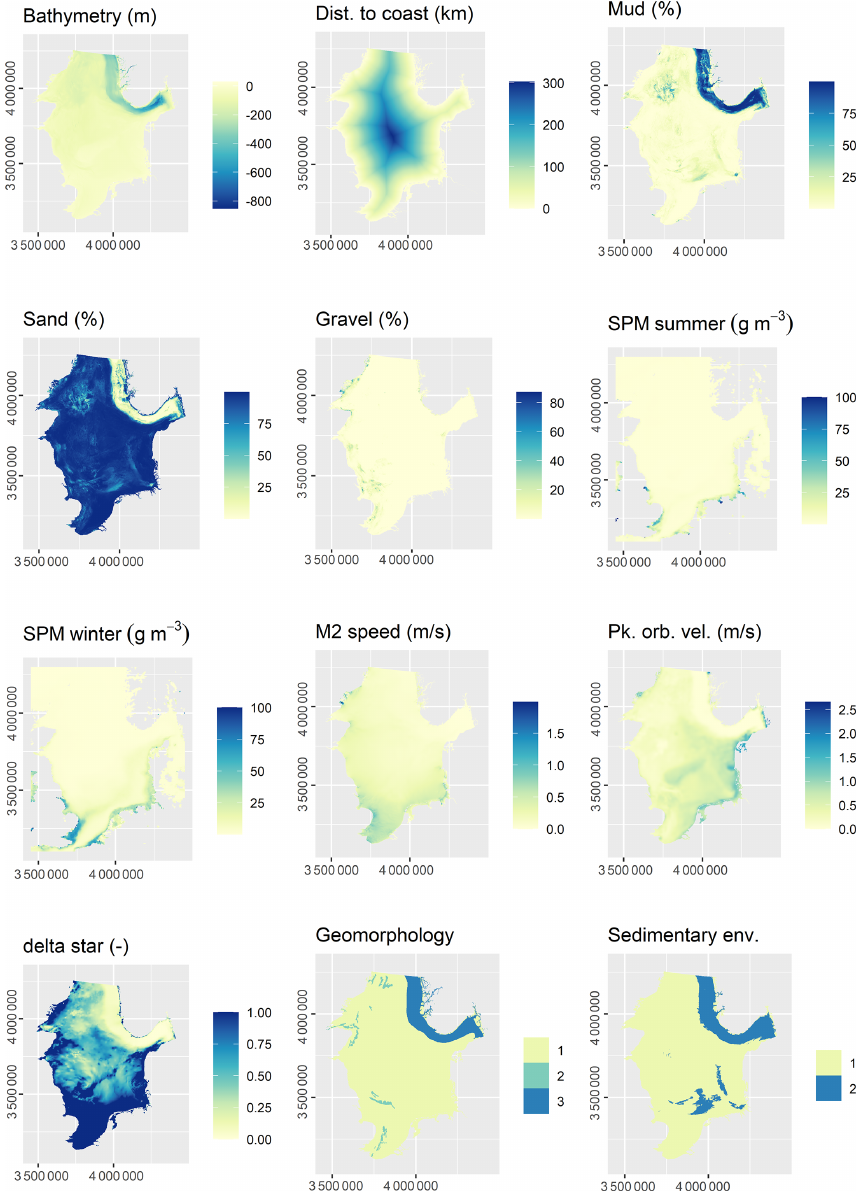
Figure A2. Selected predictor variables of the sedimentation rate model. Geomorphology: 1 – shelf, 2 – shelf valley, and 3 – glacial trough. Sedimentary environment: 1 – erosion/non-deposition and 2 –